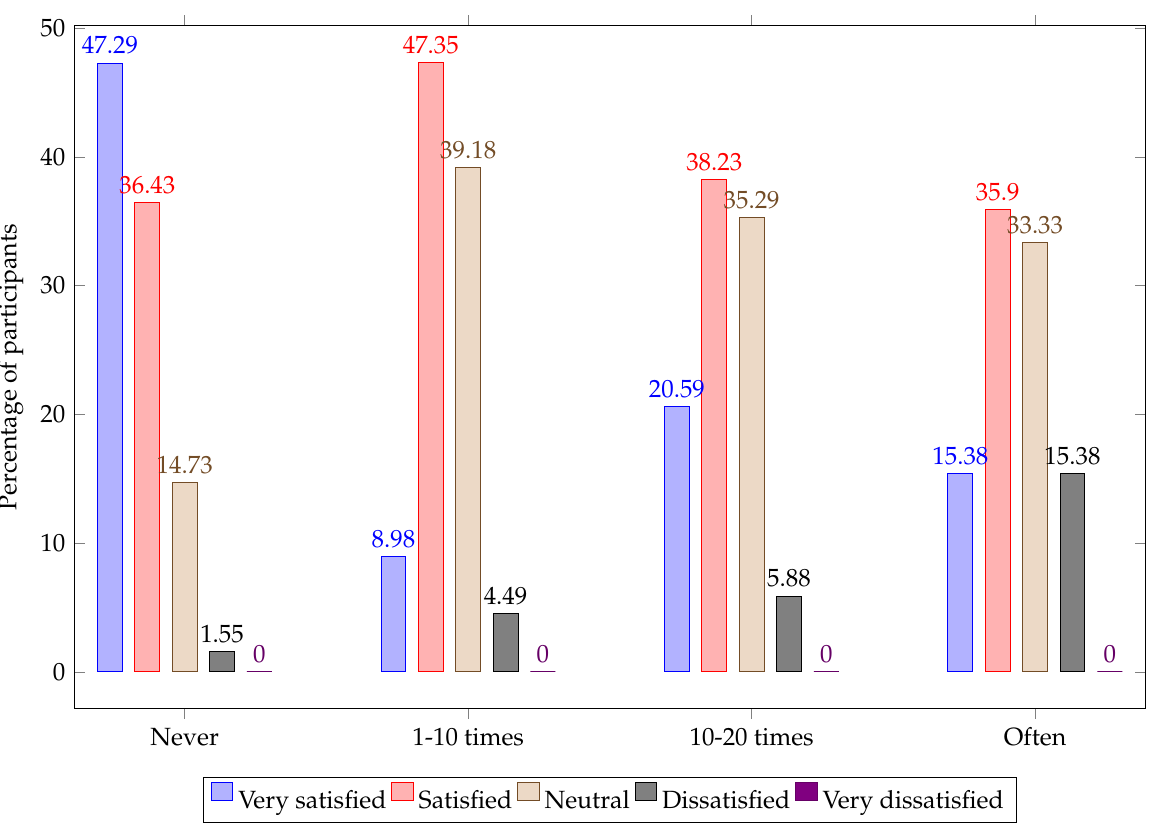
Figure 2. The satisfaction levels with their completed submissions by different frequencies of student engagement in